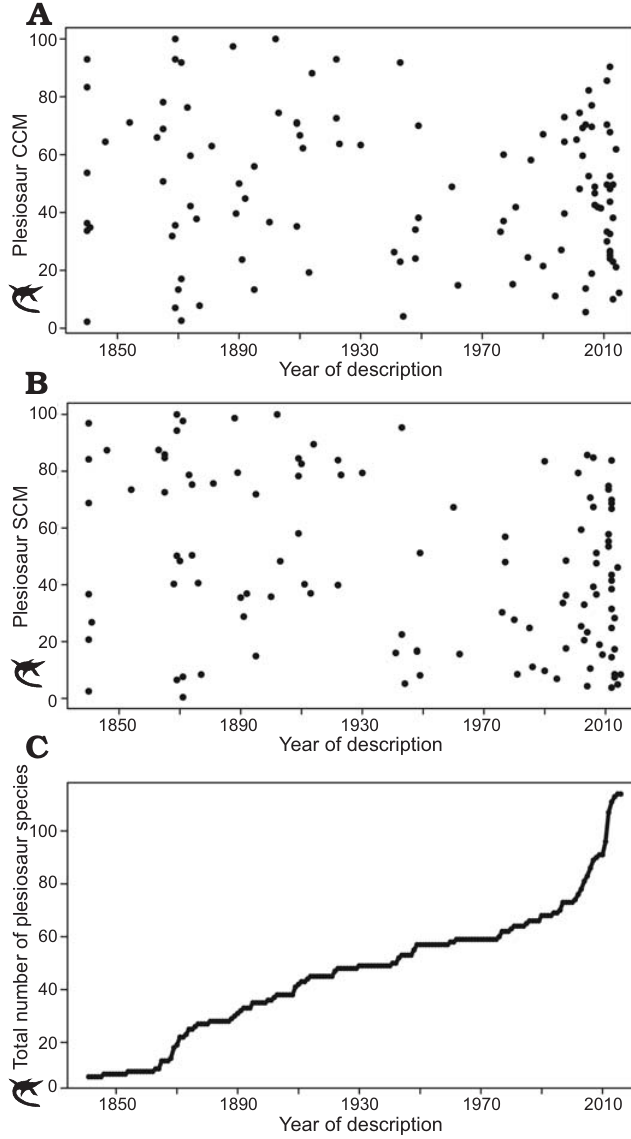
Fig. 6. Plesiosaur completeness and discovery through historical